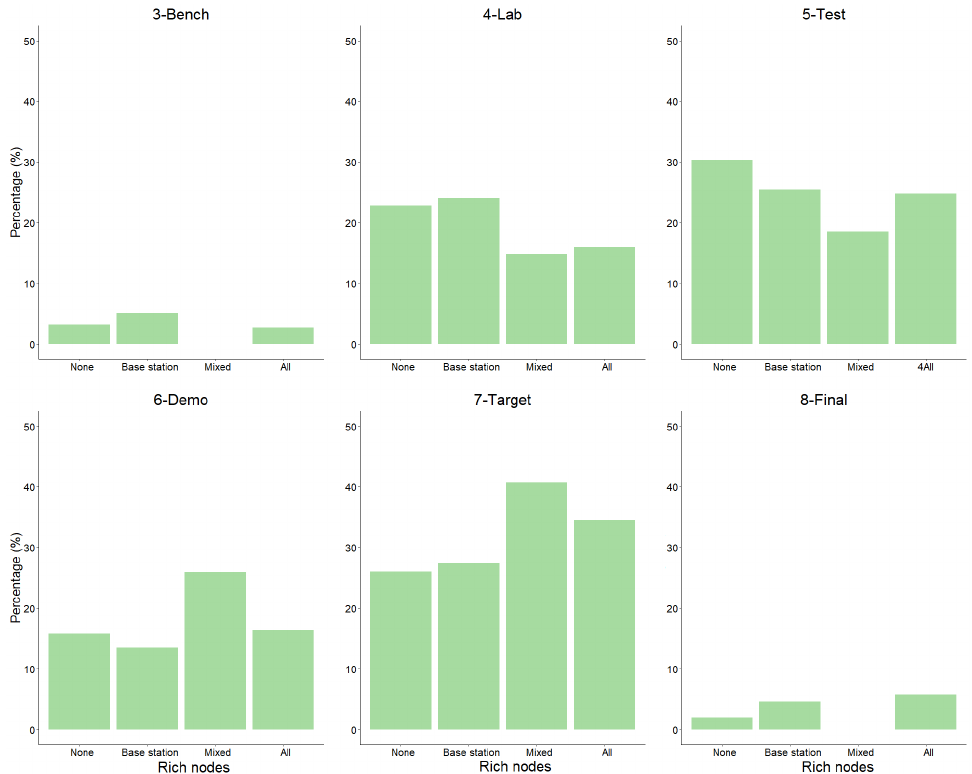
Figure 15. Deployment distribution between usage of rich nodes and